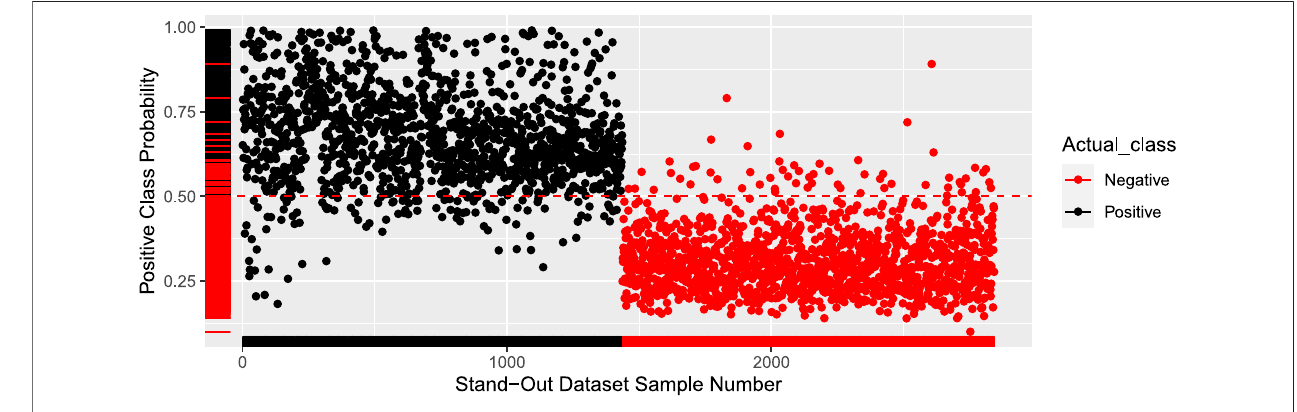
FIGURE 2 | Prediction probability